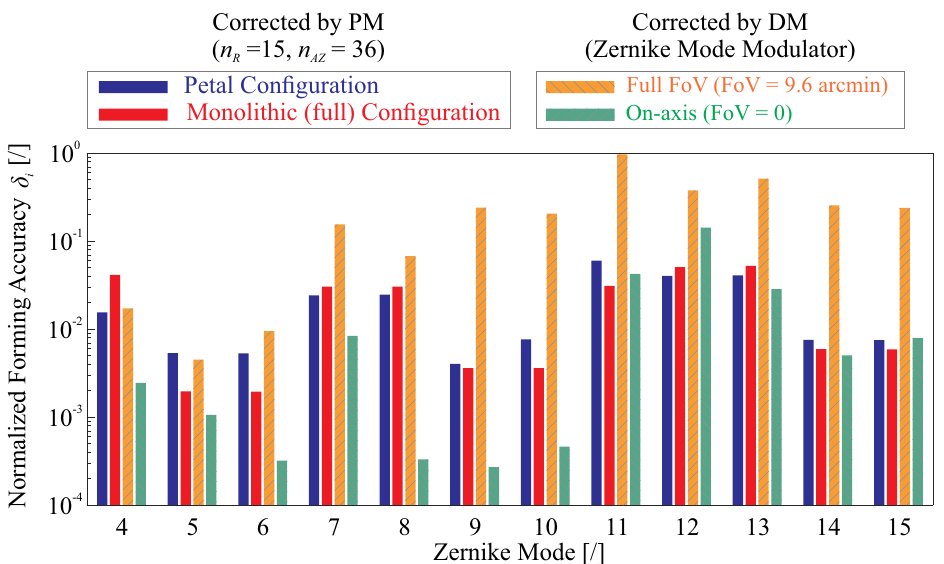
Figure 14. Evaluation of capabilities of wavefront correction for active primary and relay mirrors: the primary mirror has a keystone electrode pattern with n R = 15 and n AZ = 36 with both petal-like and monolithic configurations plotted; the effect of FoV on the optical error compensation with the deformable mirror is